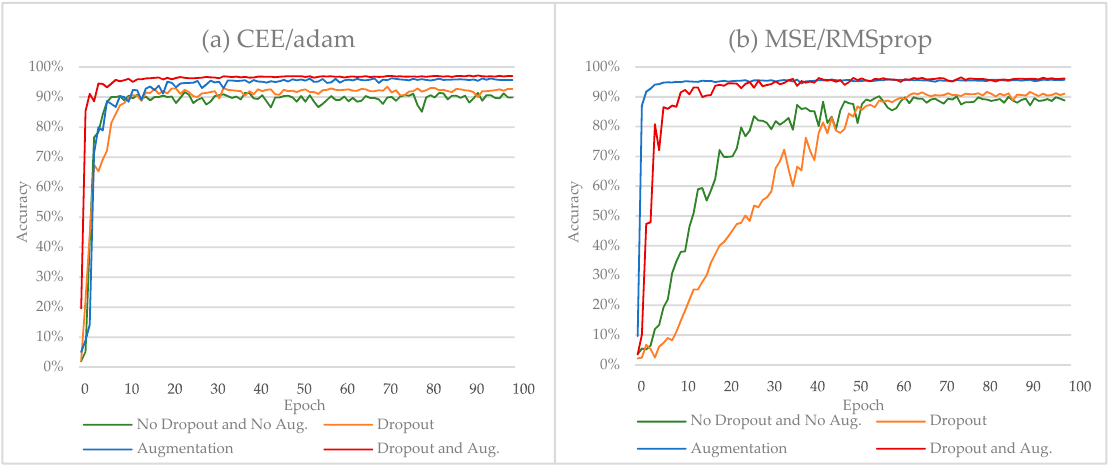
Figure 7. The performance of Alphanumeric VGG net over HACDB database using different error criteria. ( a ) CEE/adam; ( b ) MSE/RMSprop.